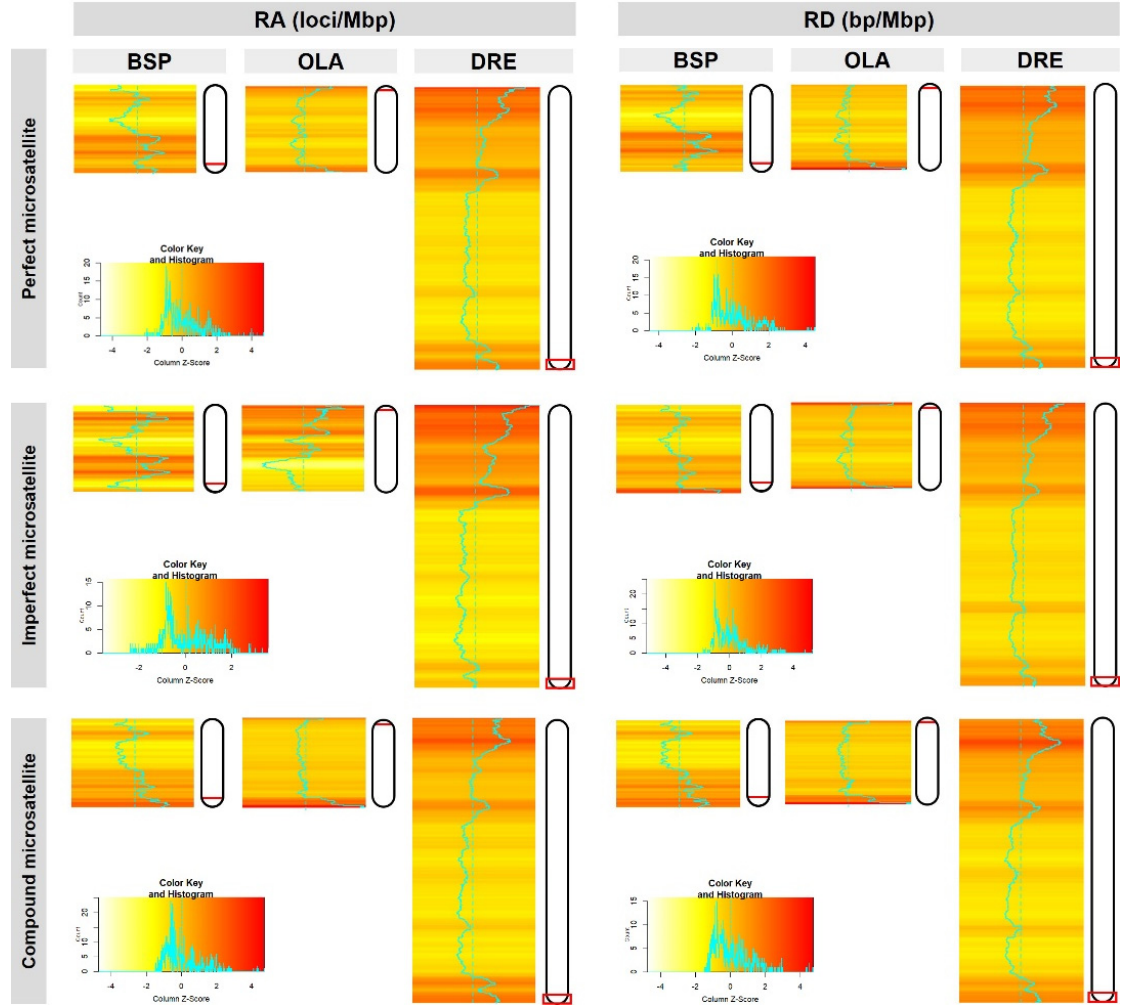
Figure 4. Microsatellite abundance and density in the sex chromosome of Siamese fighting fish (BSP) ( Betta splendens , Regan, 1910, Chromosome 9) [2], Japanese rice fish (OLA) ( Oryzias latipes , Temminck and Schlegel, 1846. Chromosome 9) [54], and zebrafish (DRE) ( Danio rerio , Hamilton, 1822, Chromosome 4) [53].